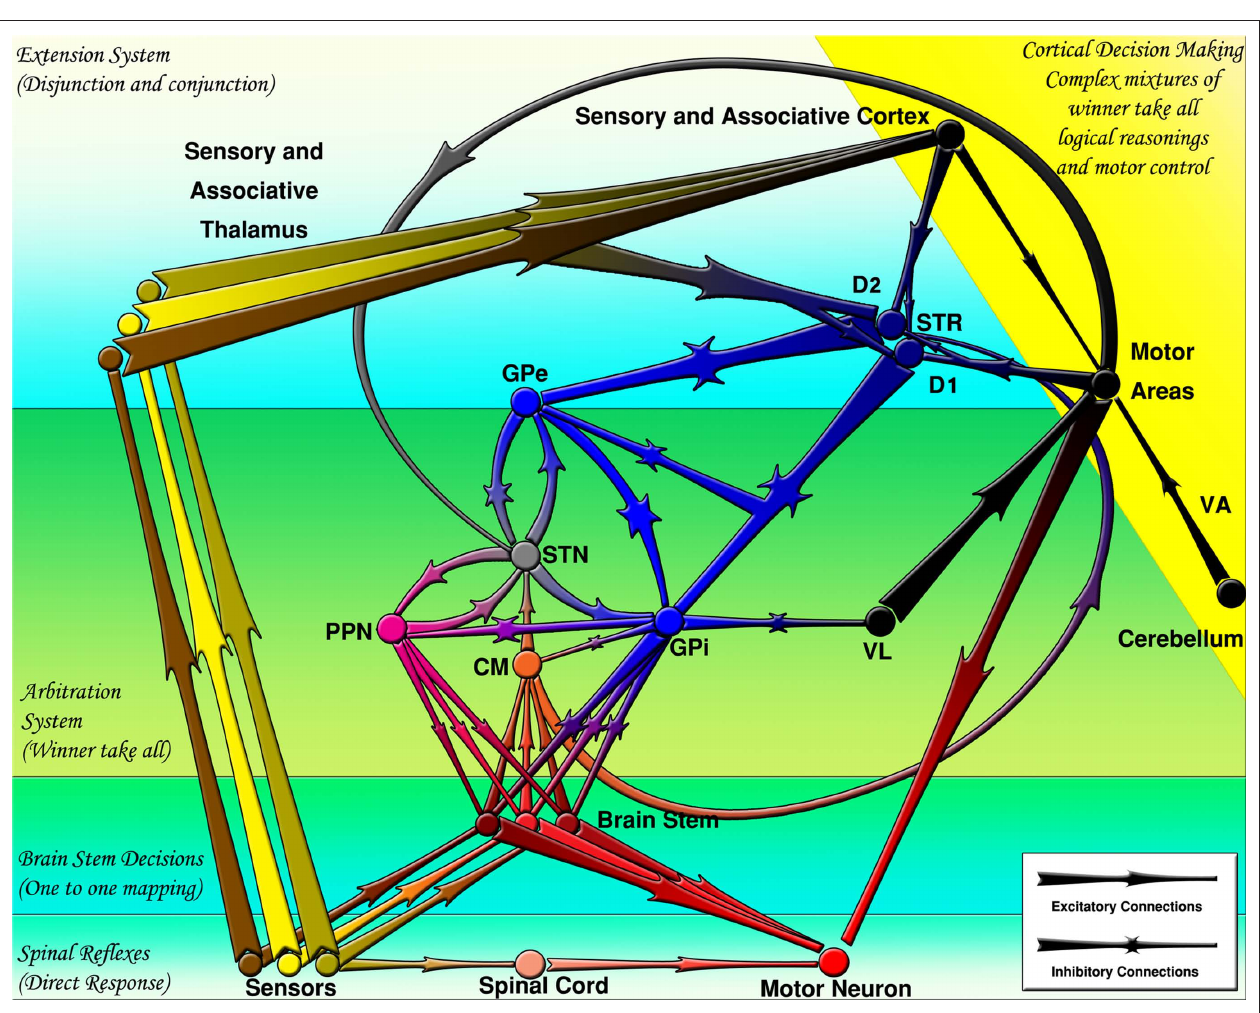
spiny neurons; D2, D2 receptor dominant medium spiny neurons; GPe, external globus pallidus; GPi, internal globus pallidus; PPN/MLR, pedunculopontine nucleus; STN, subthalamic nucleus; STR, striatum; VA, ventral anterior thalamus; VL, ventral lateral